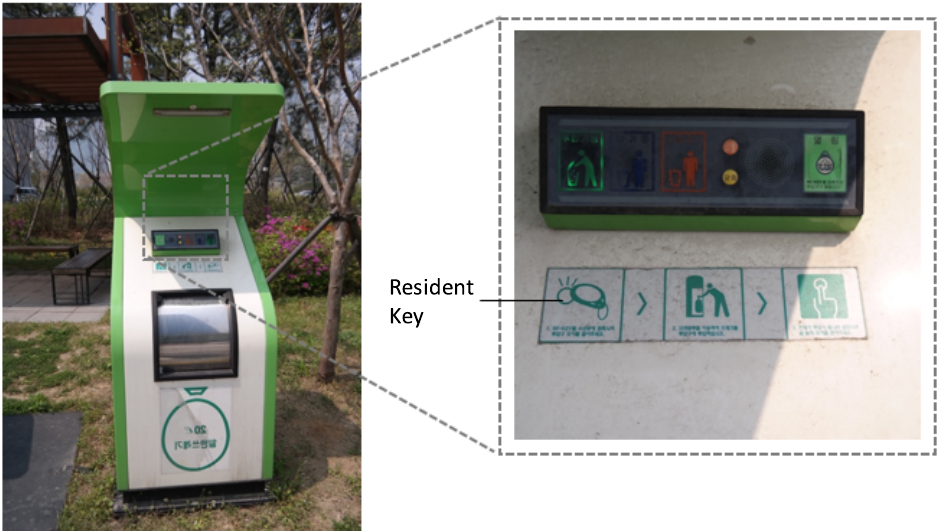
Figure 3. Photo of street-accessed waste bin system. Source: Author (20 February 2015). Urban Planning, 2017, Volume 2, Issue 2, Pages